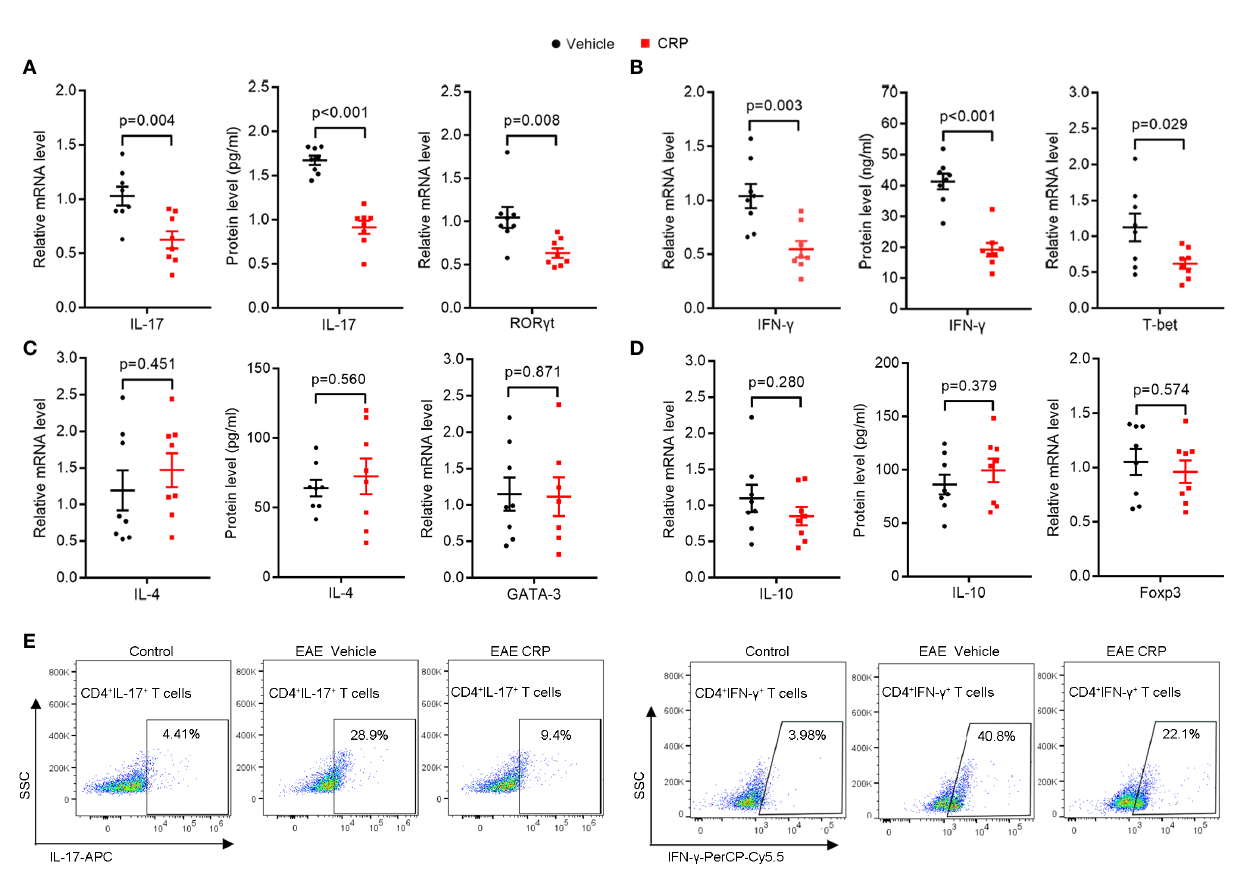
FIGURE 1 | The Th17 responses are suppressed by one-dose CRP injection in WT EAE mice.Splenocytes were isolated form EAE and EAE CRP mice, then re- stimulated with 50 ug/ml MOG 24 h for qPCR, 72 h for ELISA and FACS. (A) Th17 relevant cytokine (IL-17) and transcription factor (ROR g t) were examined by qPCR and ELISA (n = 8). (B) Th1 relevant cytokine (IFN- g ) and transcription factor (T-bet) were measured by qPCR and ELISA (n = 8). (C) Th2 relevant cytokine (IL-4) and transcription factor (GATA-3) were detected by qPCR and ELISA (n = 8). (D) Th2 relevant cytokine (IL-10) and transcription factor (Foxp3) were tested by qPCR and ELISA (n = 8). (E) Th17 (CD4 + IL-17 + ) and Th1 (CD4 + IFN- g + ) cells were examined by FACS (n = 3). Data are presented as mean ± SEM; p < 0.05 was considered statistically signi fi